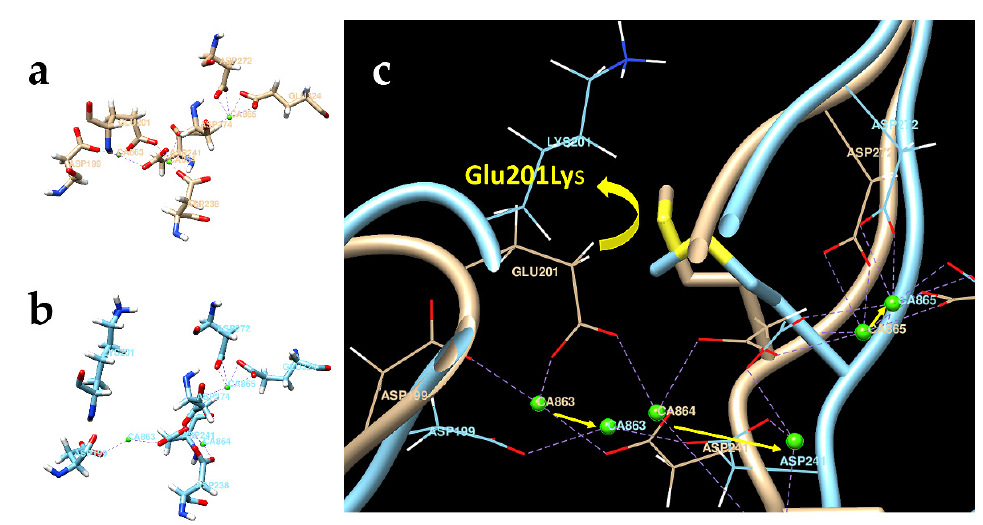
Figure 5. The pathogenic variant Glu201Lys is predicted to decrease Ca 2+ binding to the CDHR1 protein. Glu201Lys is confined in the interface area between cadherin domains CA-2 and CA-3. Ca 2+ is shown by green spheres. ( a ) In the normal CDHR1 protein structure (beige), Ca 2+ -binding sites are formed by negatively charged residues. ( b ) In the altered CDHR1 protein p.Glu201Lys (blue), the replacement of negatively charged Glu with positively charged Lys decreases Ca 2+ binding. ( c ) The superposition of the normal CDHR1 and the p.Glu201Lys proteins was refined using 11 ps computer simulation. Yellow arrows show the movement of Ca 2+ ions.